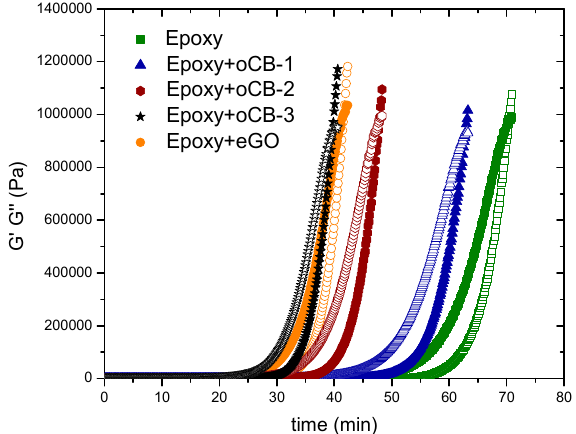
Figure 4. Storage modulus ( G ′ , empty symbols) and loss modulus ( G ″ , full symbols) versus time for the DGEBA-IPDA epoxy resin, pure (green) or with 3 wt % of different carbon nanofillers: oCB-1 (O/C, wt/wt = 0.16) (blue); oCB-2 (O/C, wt/wt = 0.83 (wine); oCB-3 (O/C, wt/wt = 0.91) (black); eGO (O/C, wt/wt = 0.62) (orange).